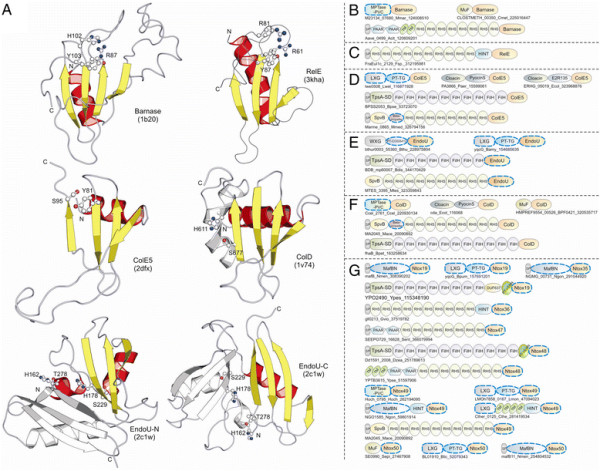
(A) Shared common core of the BECR fold illustrated with representative structures from Barnase, RelE, ColE5, ColD, and EndoU families. PDB ids are shown in brackets. All structural cartoons are shown in an approximately similar orientation. The α-helices are colored red, β-sheets yellow and loops gray. The predicted and known active site residues are labeled. Representative domain architectures of polymorphic toxins containing (B) Tox-Barnase, (C) Tox-RelE, (D)Colicin E5 (Tox-ColE5), (E) Tox-EndoU, (F) Colicin D (Tox-ColD), and (G) several other novel toxin domains predicted to contain the BECR fold. The labeling scheme for domain architectures and alignments, and the coloring scheme and consensus abbreviations are as in Figure 3.